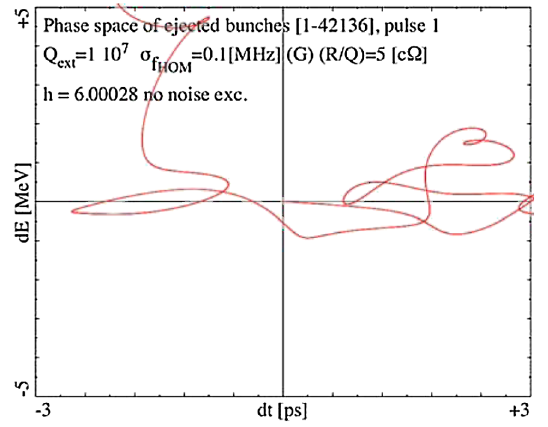
FIG. 39. (Color) Phase-space image of the ejected bunches of the second pulse. Conditions as Fig. 38 but Q ext ¼ 10 7 . The pulse was aborted after about 40 000 bunches.